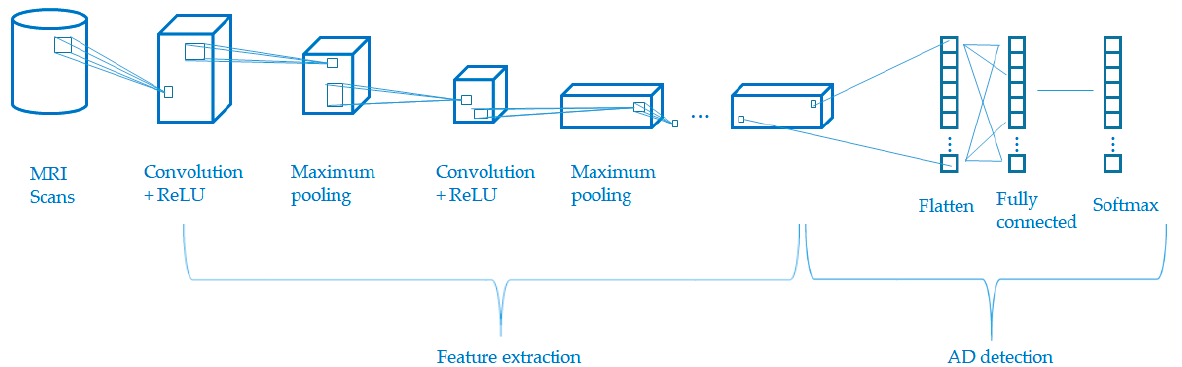
Figure 3. Feature extraction and AD detection using CNN.